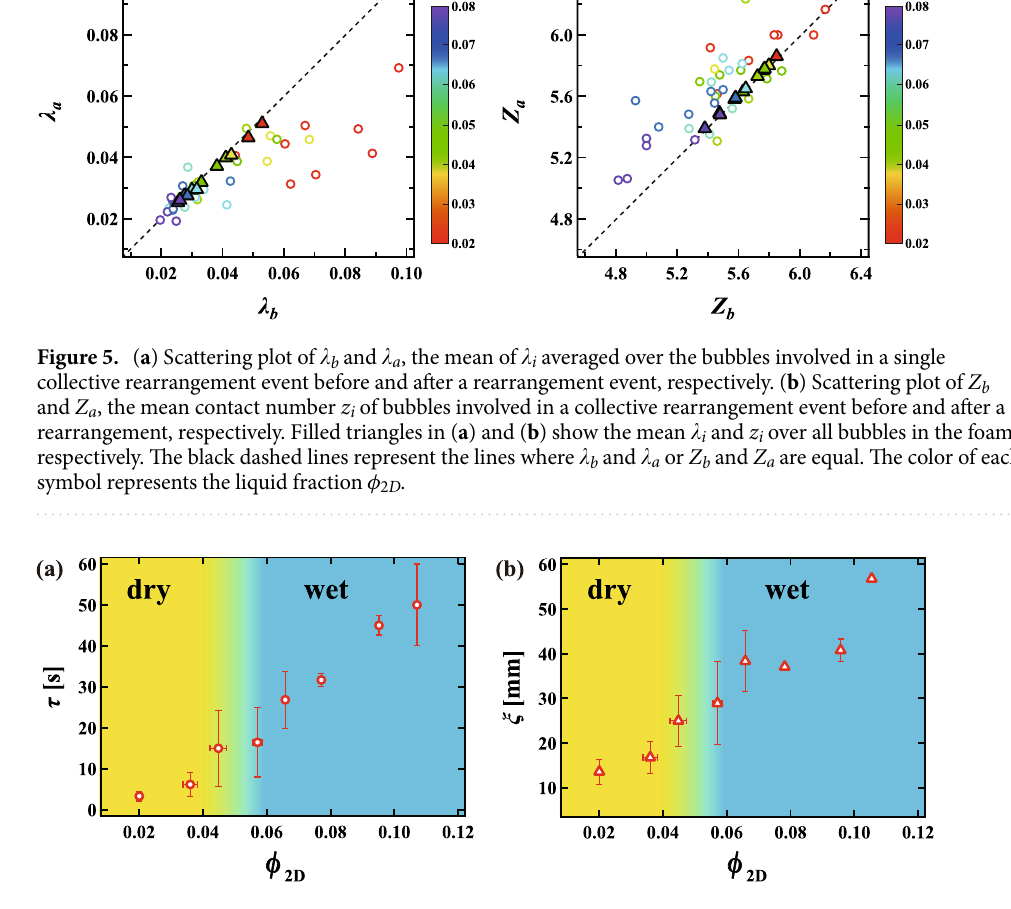
Figure 6. ( a ) The rearrangement time τ and ( b ) the correlation length ξ of macroscopic rearrangement events averaged over several collective rearrangements as a function of φ 2 D . It is found that both τ and ξ increase continuously as φ 2 D increases, that is, there is no sign of the dry-wet